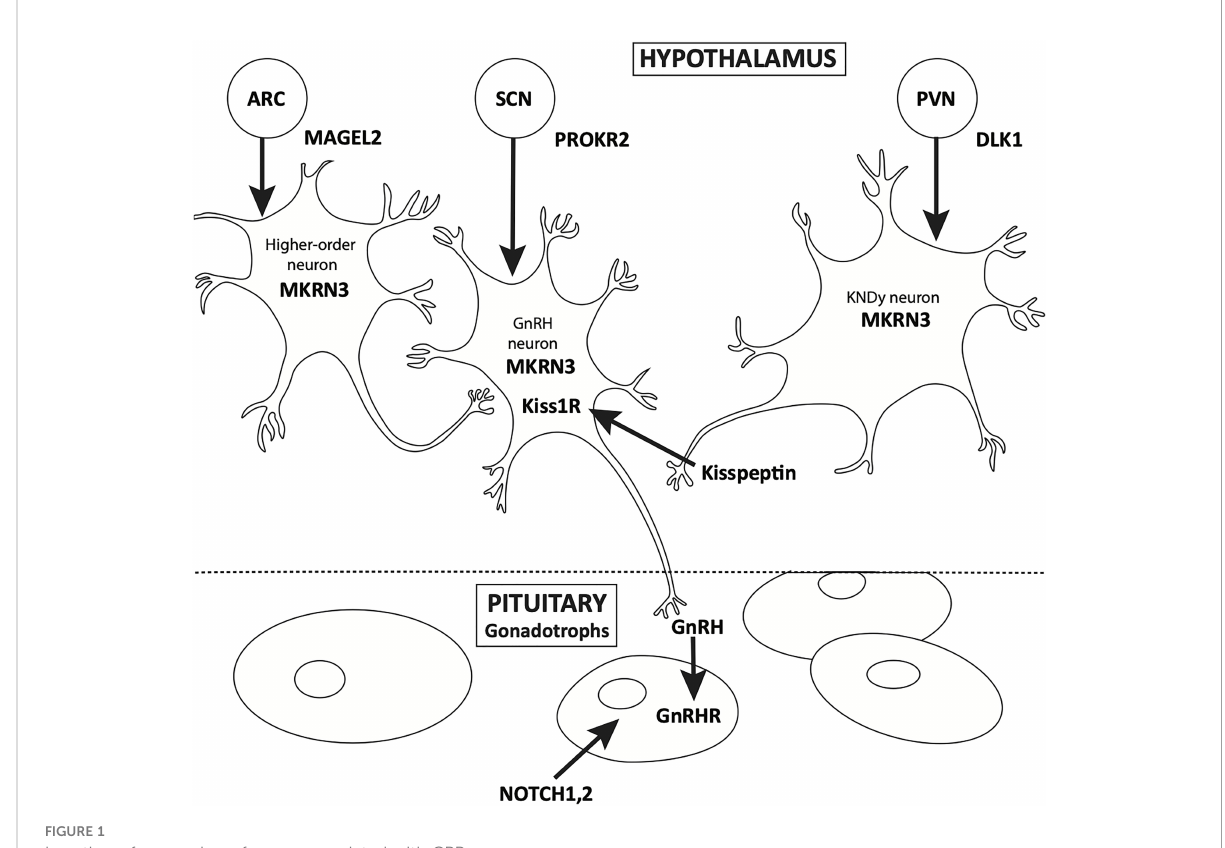
FIGURE 1 Location of expression of genes associated with CPP.